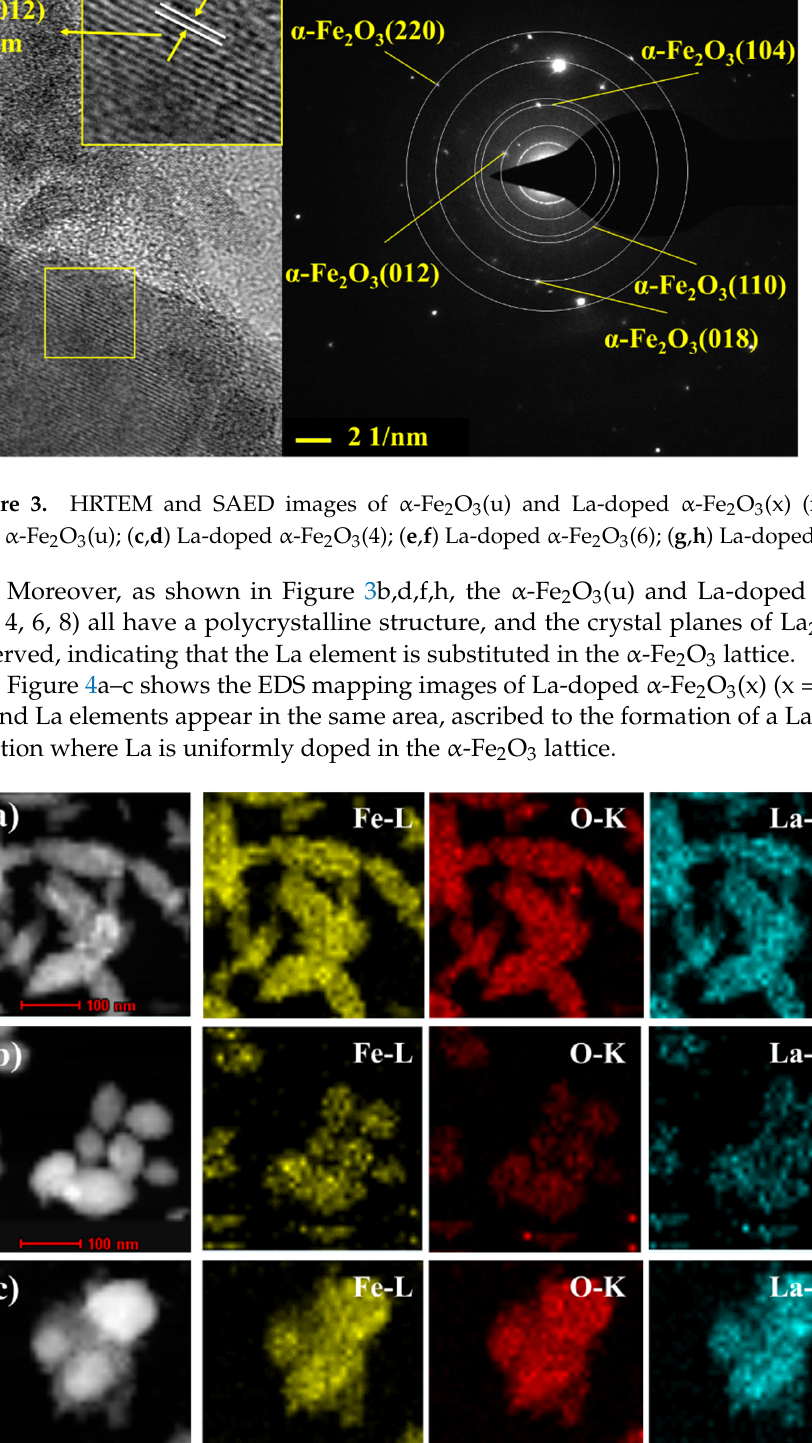
Figure 4. TEM-EDS mapping images of La-doped α -Fe 2 O 3 (x) (x = 4, 6, 8). ( a ) La-doped α -Fe 2 O 3 (4); ( b ) La-doped α -Fe 2 O 3 (6); ( c ) La-doped α -Fe 2 O 3 (8).